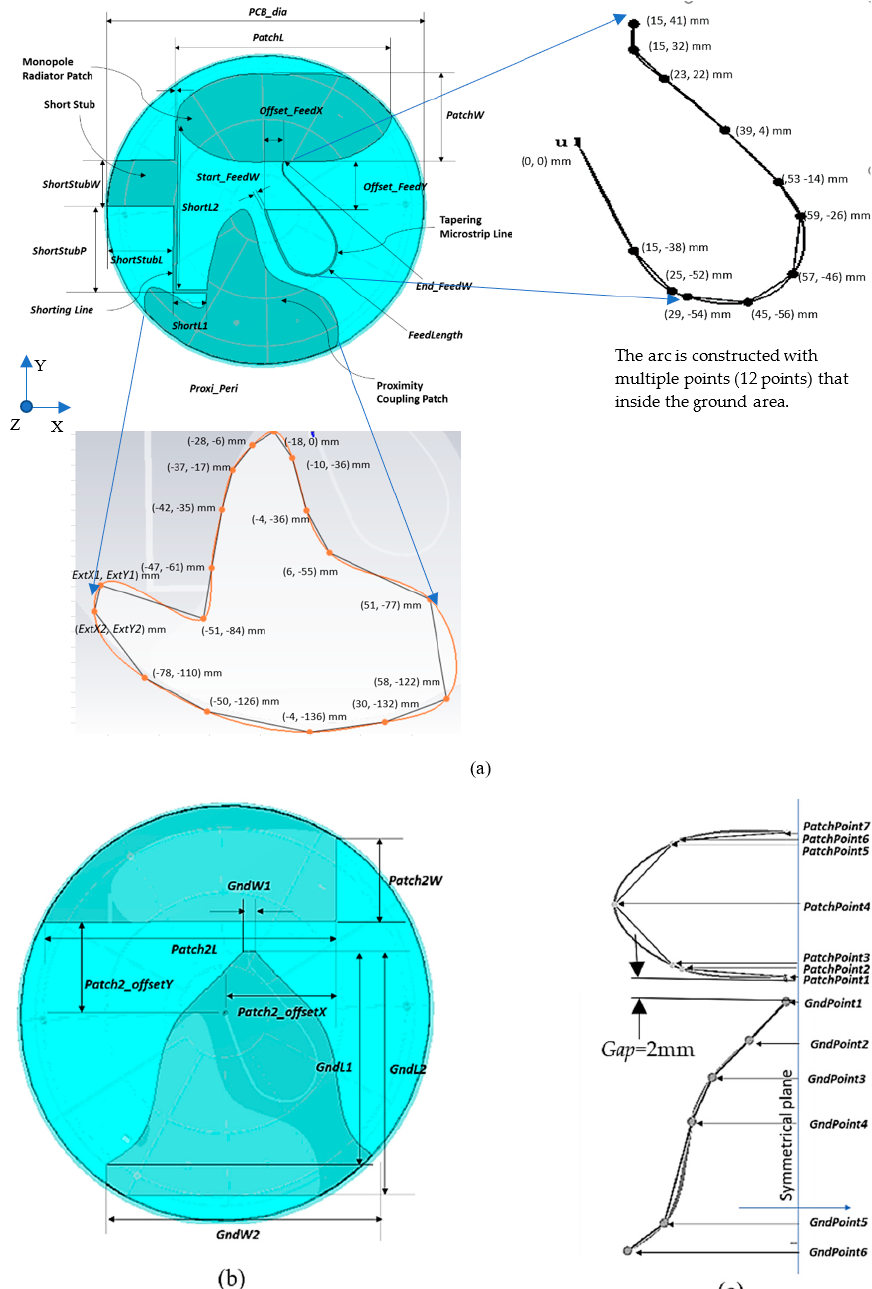
Figure 10. The internal structure of the proposed antenna with a transparent view of the substrate and radome. ( a ) The top layer, ( b ) The bottom layer, and ( c ) the spline points to construct the spline line of the patch and the ground plane.